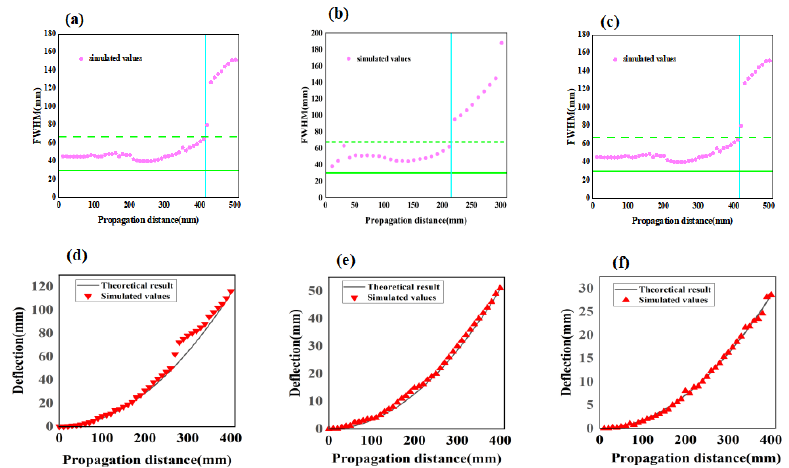
Figure 5. The non-diffracting and self-bending properties of the Airy beam generated at 10 GHz, 15 GHz, and 20 GHz were validated, ( a – c ) for non-diffraction of Airy beams, which depicts the variation of width at half maximum of the main lobe along the z-direction (The non-diffraction zone is defined as the area between the green dashed and solid green lines, with a value of 1.5 times the mean FWHM value of the initial main beam. An oscillating pattern is observed in this zone, the area after the blue line represents the diffraction zone); ( d – f ) for the self-bending property of the Airy beam, (which demonstrates the deflection of the main beam versus propagation distance (z-direction) calculated from theory and simulation.).